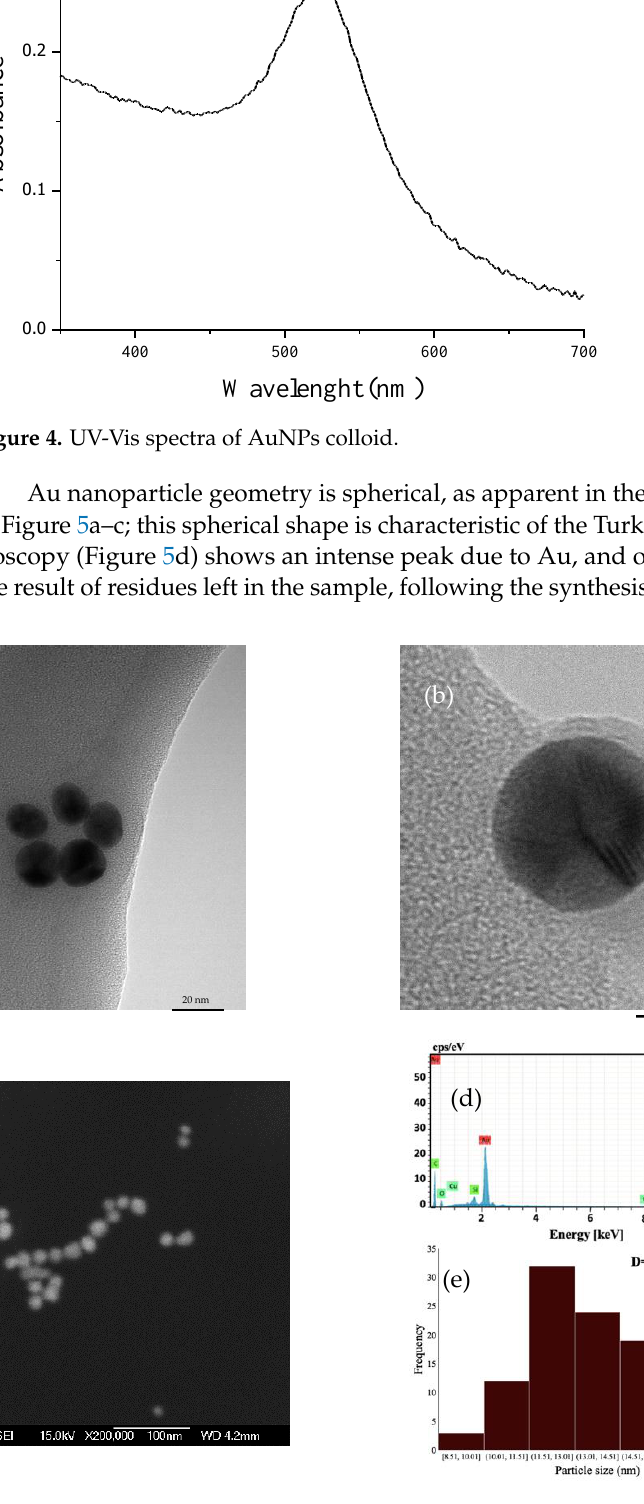
Figure 5. ( a ) TEM microscopy images of AuNPs, ( b ) a single Au particle, ( c ) SEM image of AuNPs, ( d ) EDS elemental analysis, and ( e ) particle size distribution of AuNPs.